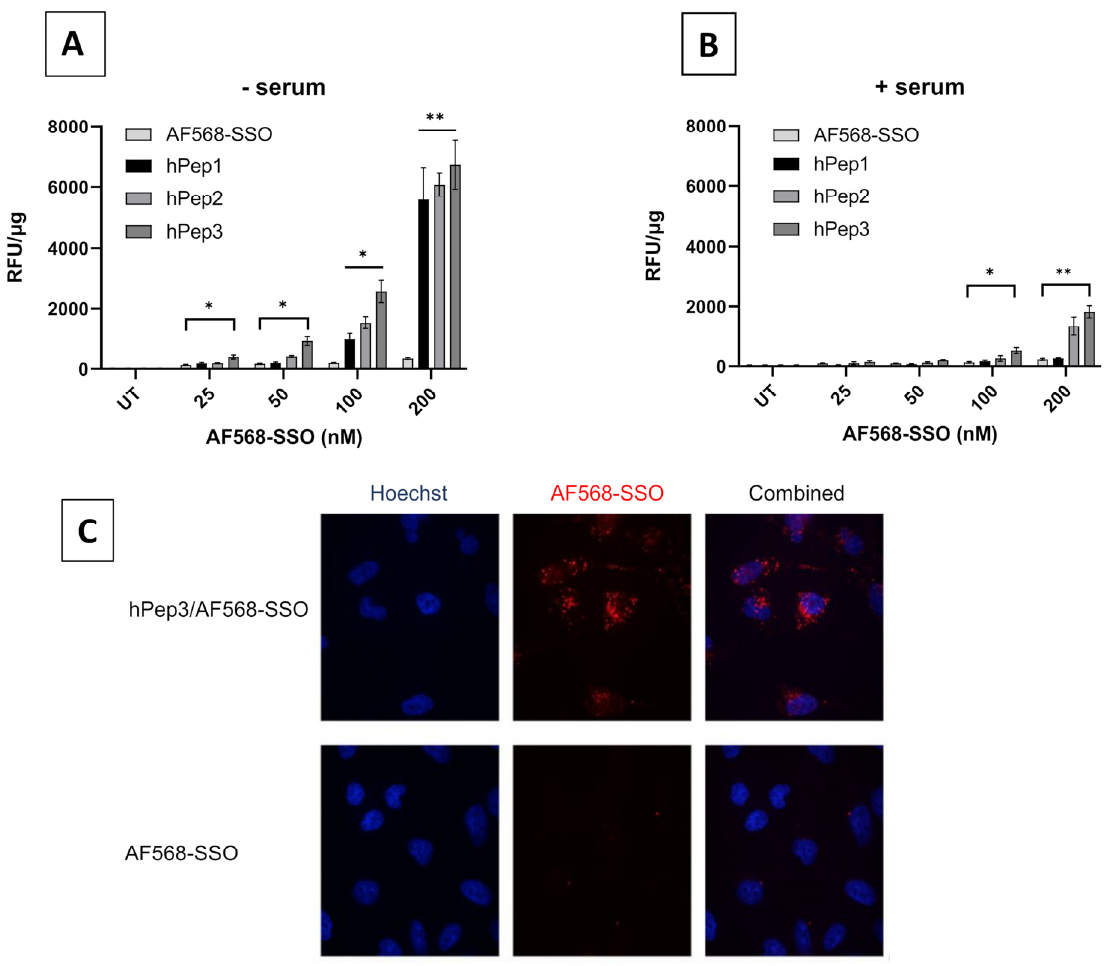
Figure 5. Quantitative uptake and intracellular localization of hPep/SSO nanoparticles in HeLa 705 cells. For quantitative uptake studies, cells were treated for 4 h over a range of concentrations with AF568-SSO complexes formulated both in ( A ) serum-free and ( B ) serum-containing media and the uptake was analyzed by fluorescence spectroscopic analysis. ( C ) Cellular localization of hPep3/AF568-SSO nanoparticles (red) was followed by live cell imaging with confocal microscopy 4 h after the treatments. Then the nuclei were stained with Hoechst (blue). The presented values are the mean of at least three independent experiments conducted in duplicates (mean ± SEM). p -values were determined by one-way ANOVA with Dunnett ′ s multiple comparison test (* p < 0.05, ** p < 0.01).